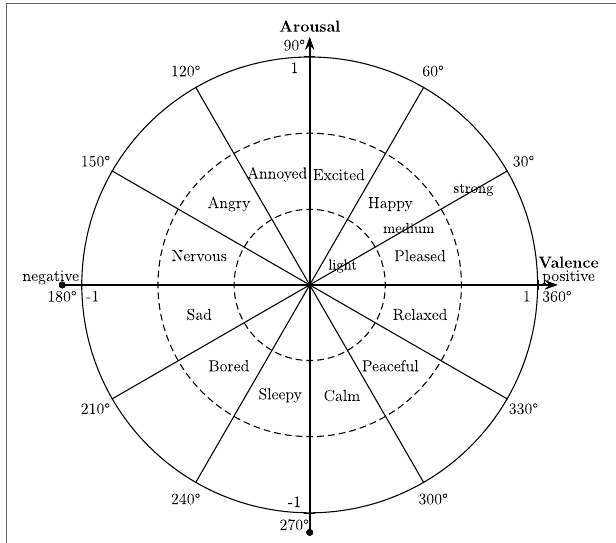
FIGURE 2 | Circle of emotion, arousal, and valence (Thayer, 1989; Salmeron, 2012)